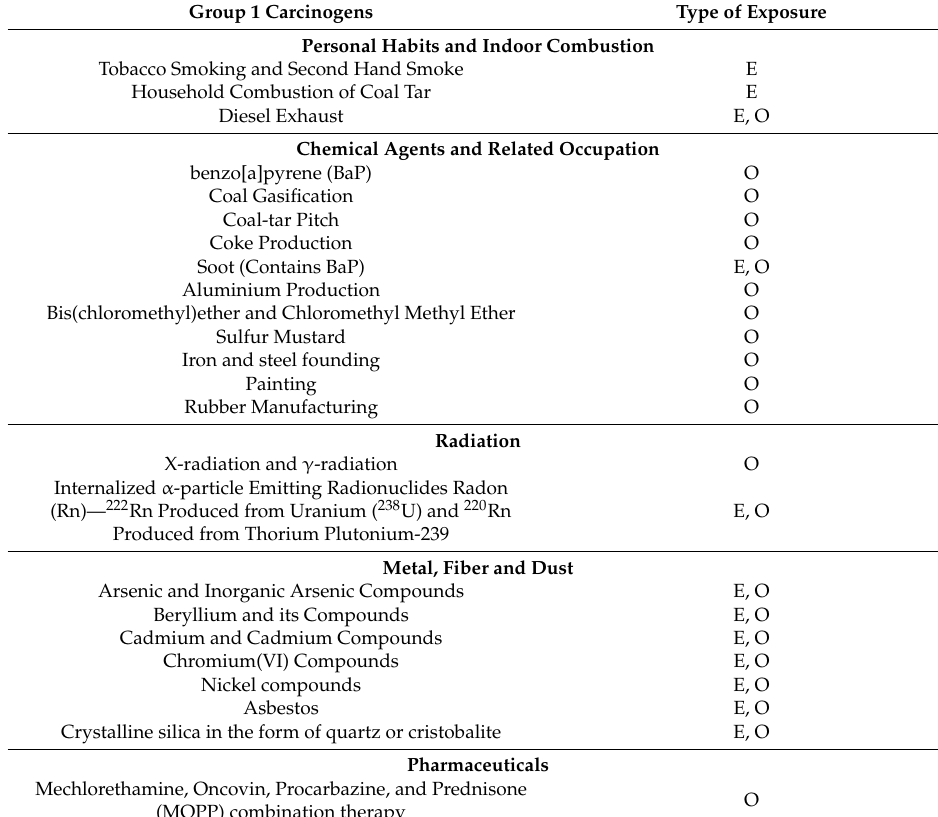
Table 2. Group I lung carcinogens classified by International Agency for Research on Cancer (IARC)